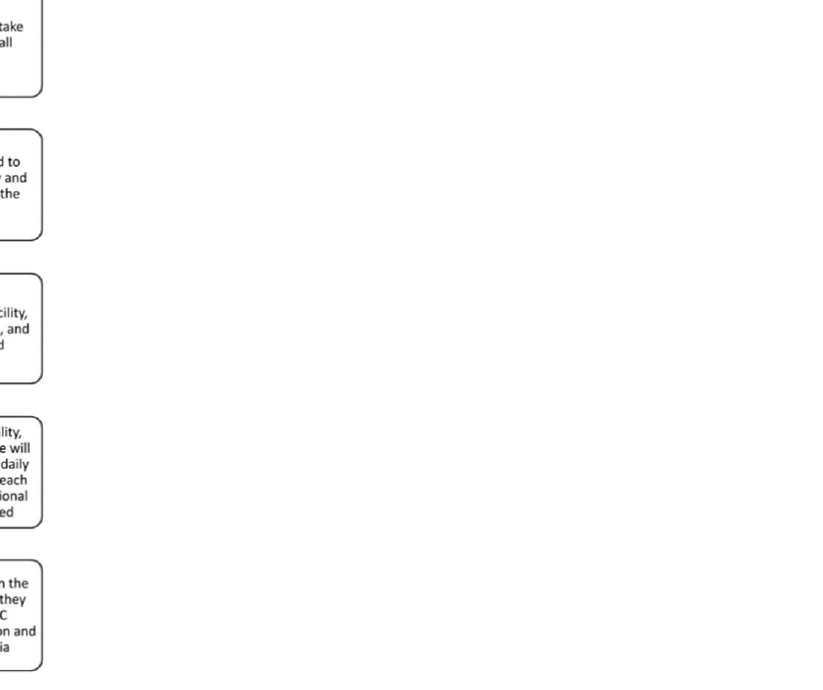
Table 1. Roles and Responsibilities of Key Functional Teams in the Isolation and Quarantine System,